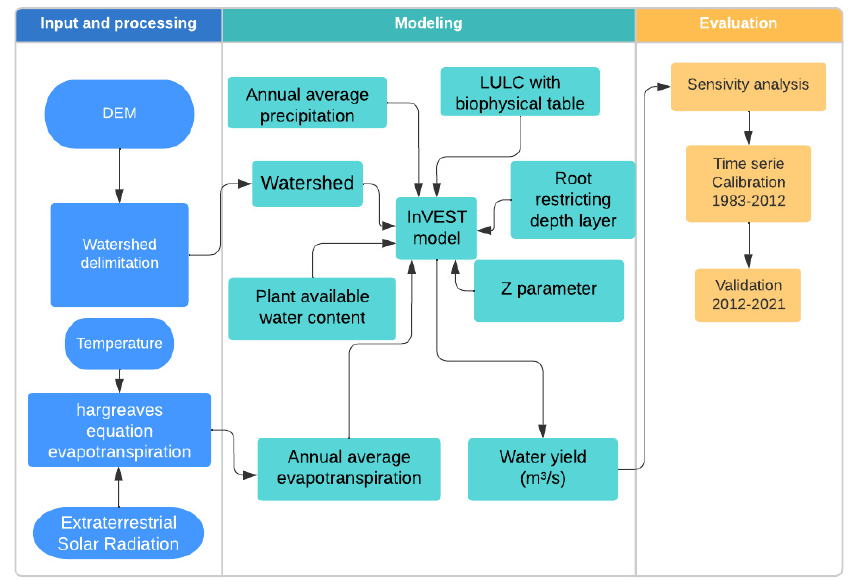
Figure 3. Methodology flowchart for calculation of water yield in the Meta River basin using the InVEST–AWY model.